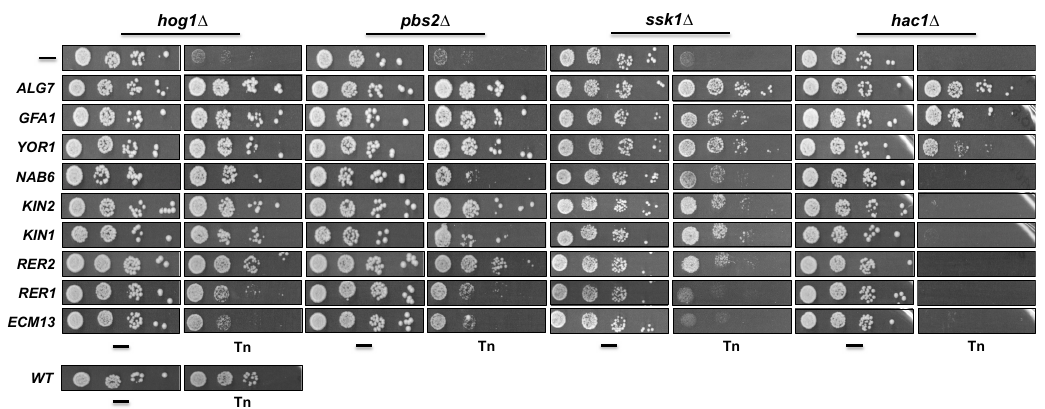
Figure 3. Effect of expression of suppressor genes in the Tn sensitivity of different strains. The suppressor genes were overexpressed in the indicated strains as described in Figure legend 2C. A serial dilution assay was performed as described (Figure legend 2B). Plates were incubated at 30 °C for 72 h and scanned. Table 1. General and specific suppressors and the cellular process where they participate.